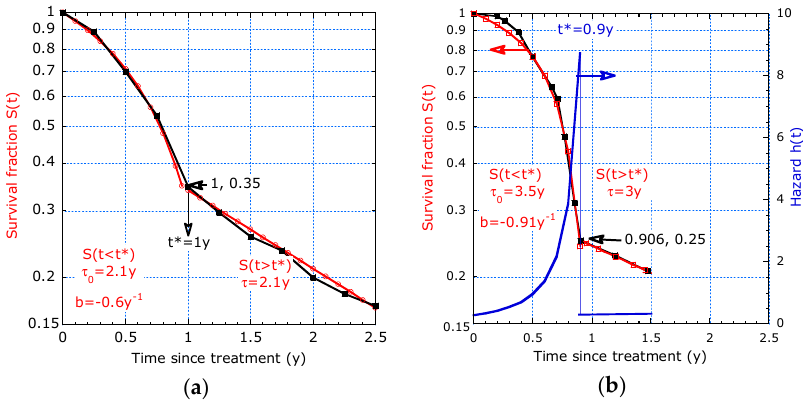
Figure 11. The survival curves (solid squares) from [16] with a clear transition time t* and curve fits (open squares) in distinct time intervals, starting with accelerated aging and switching abruptly to a lower constant hazard. The log-lin presentation reveals t* and the fit parameters before and beyond t * : ( a ) Figure 11a is from the complete group (111 patients) [16], Fig 1; ( b ) Figure 11b is from 33 patients stratified by prognostic group (intermediate) [16]. The right scale shows the discontinuity in the hazard.